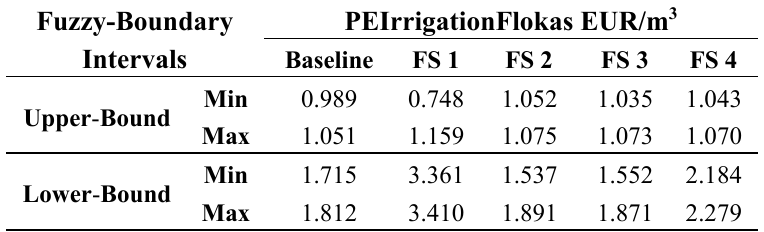
Table 6. Lower- and upper- fuzzy-boundary intervals for the unit penalties for water deficits to irrigation EUR/m 3 for the baseline and the future